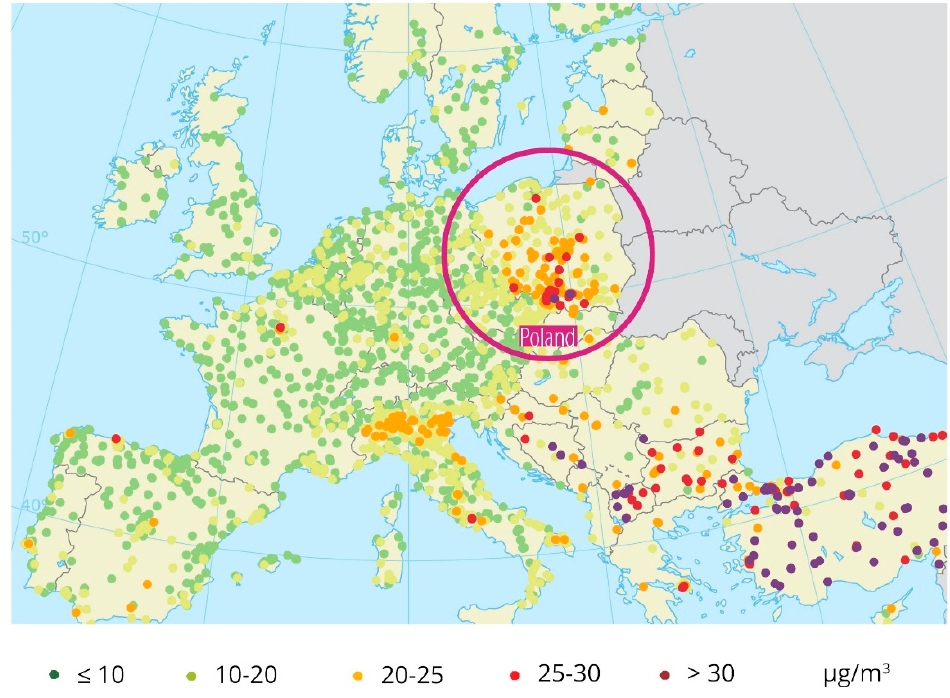
Figure 3. Concentration of PM2.5 in Poland and Europe in 2016 (based on Reference [28]).